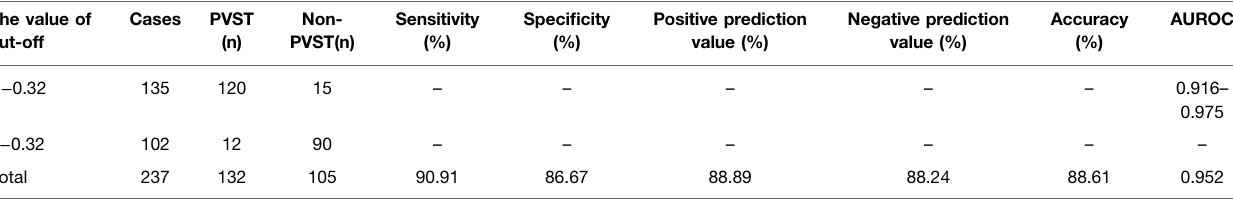
TABLE 6 | Combined prediction of PVST based on meaningful factors called Logit P. a